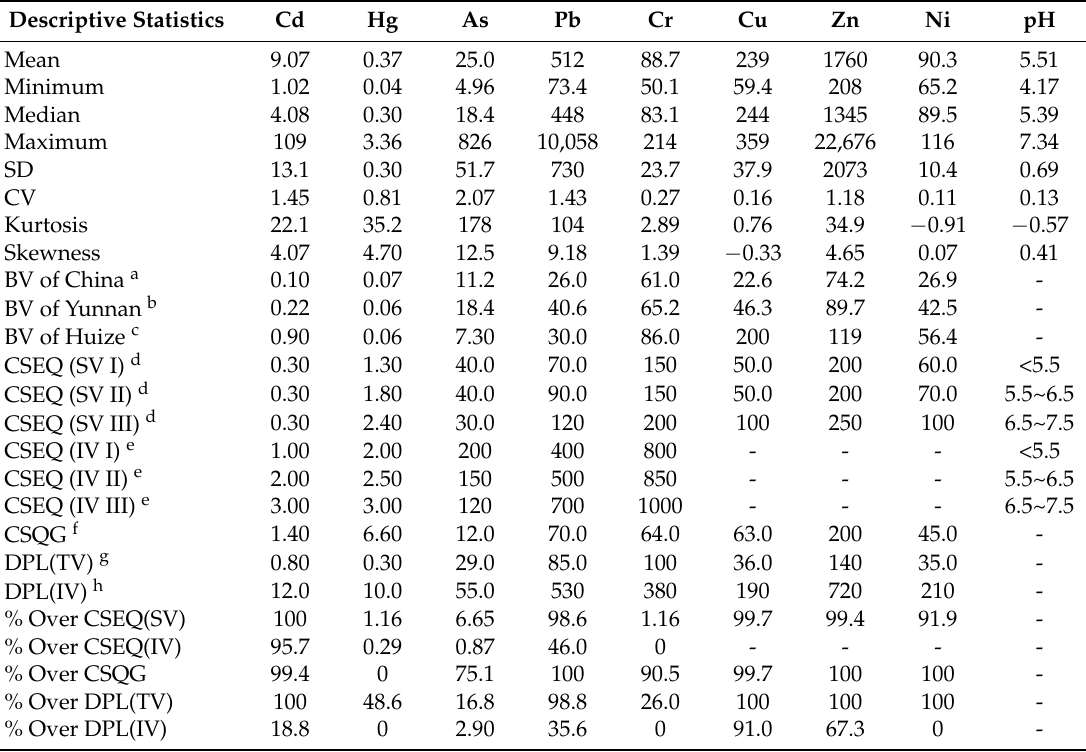
Table 1. Descriptive statistics of metals concentrations (mg/kg) and pH of topsoil in